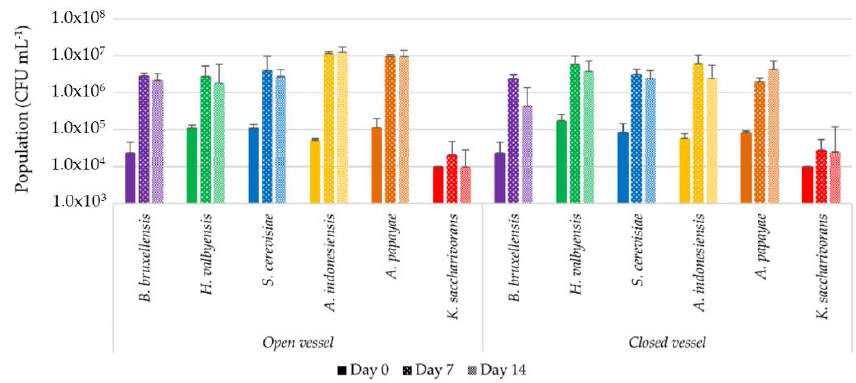
Figure 1. Microbial populations during cultivation in sugared black tea of a monoculture of yeast and bacterial strains isolated from black tea kombucha determined by plate counting (CFU mL − 1 ). Error bars correspond to the confidence interval with α = 0.05 ( n = 3). Cultures were conducted in open vessel (left) or closed (right) conditions of incubation for 14 days.